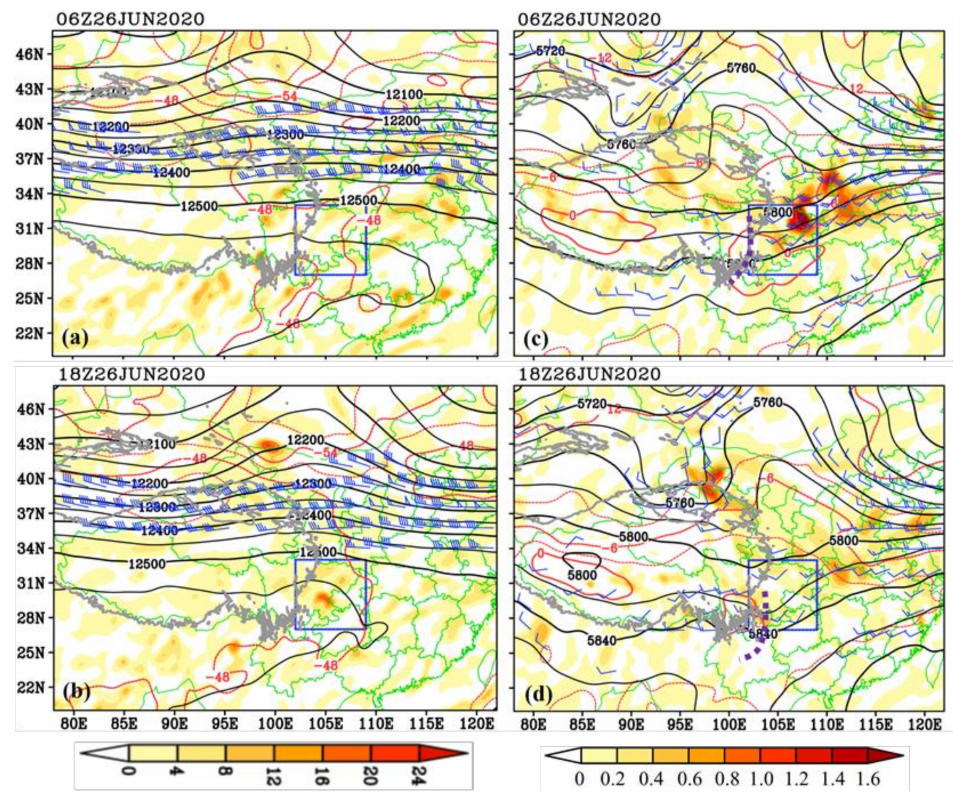
Figure 2. Panels ( a , b ) show the divergence (shading, units: 10 − 5 s − 1 ), geopotential height (black contours, units: gpm), temperature (red contours, units: ◦ C), and wind exceeding 35 m s − 1 (a full wind bar is 10 m s − 1 ) at 200 hPa. Panels ( c , d ) illustrate the temperature advection (shading, units: K h − 1 ), geopotential height (black contours, units: gpm), temperature (red contours, units: ◦ C), and wind exceeding 10 m s − 1 (a full wind bar is 10 m s − 1 ) at 500 hPa, where the purple dashed lines are the trough lines. The grey solid lines outline the terrain of 3000 m, and the blue dashed boxes show the SWV’s key